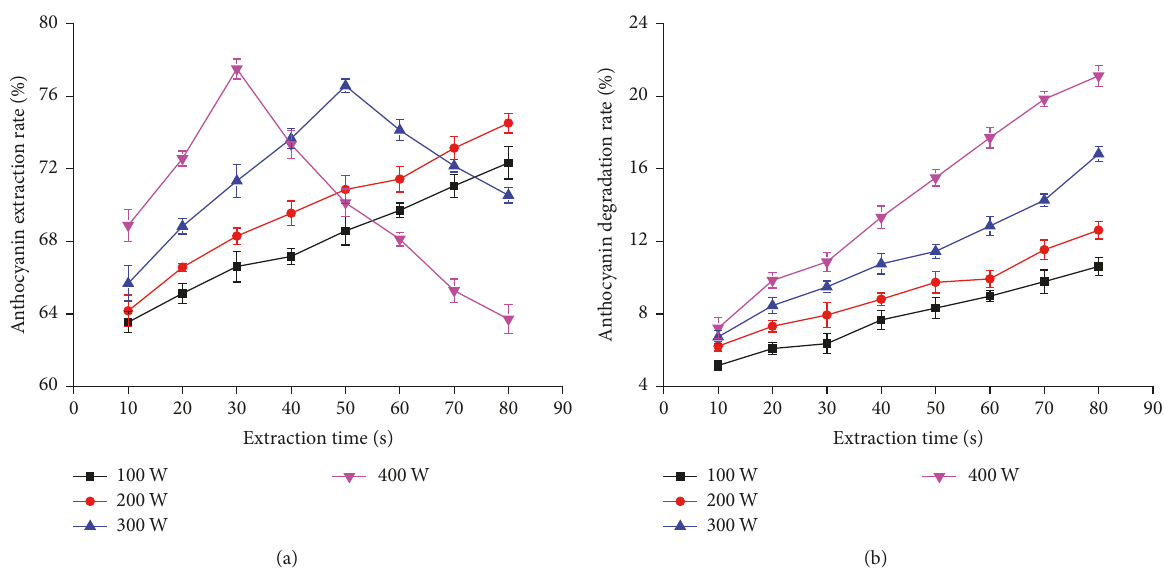
Figure 8: Effects of microwave power on anthocyanin yield (a) and degradation rate (b).